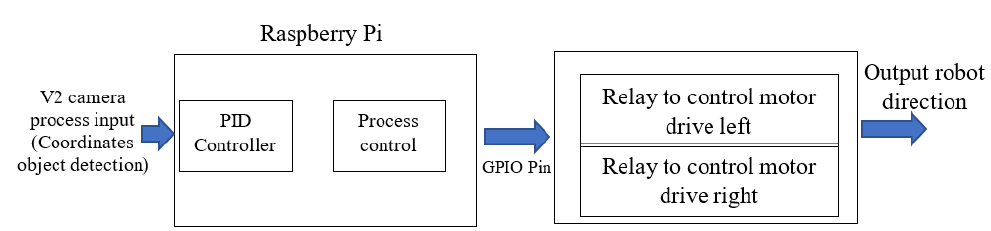
Figure 14. Raspberry Pi PID robot controller. The selected color is used to identify and choose shoppers in crowded areas. The RGB color is detected from the video camera read and then transformed to the HSL color space. The HSL color space causes the chromatic data to be independent of the lighting brightness. According to the object coordinate detection result, the GPIO relays the order to the motor driver to steer the robot in the left or right direction based on the camera filter data. The flowchart of the system algorithm is shown in Figure 15.